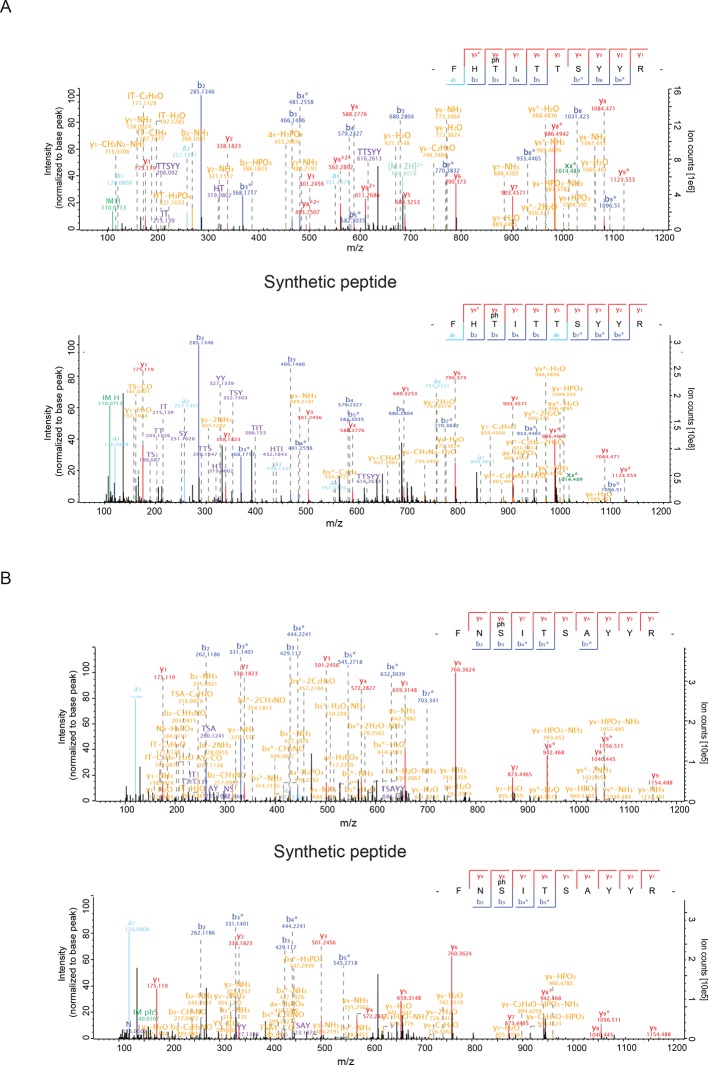
HCD MS/MS spectra of synthetic Rab peptides(A) Higher energy collision-induced dissociation (HCD) MS/MS spectra of the pT73-Rab10 peptide identified in PS2. The spectrum of the corresponding synthetic peptide is shown below. (B) Same as (A) but pS105-Rab12.